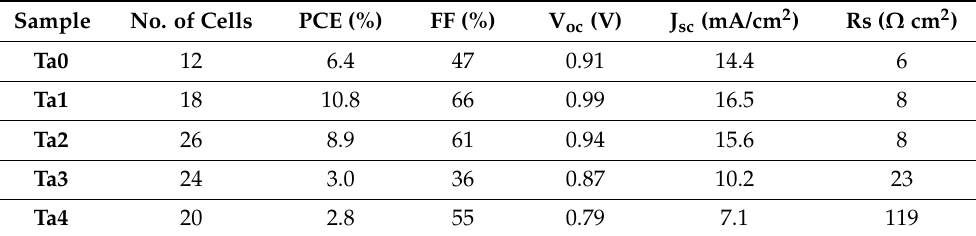
Table 2. Photovoltaic parameters of PSCs, using amorphous Ta 2 O 5 layers of different thicknesses (Ta0–Ta4) as their